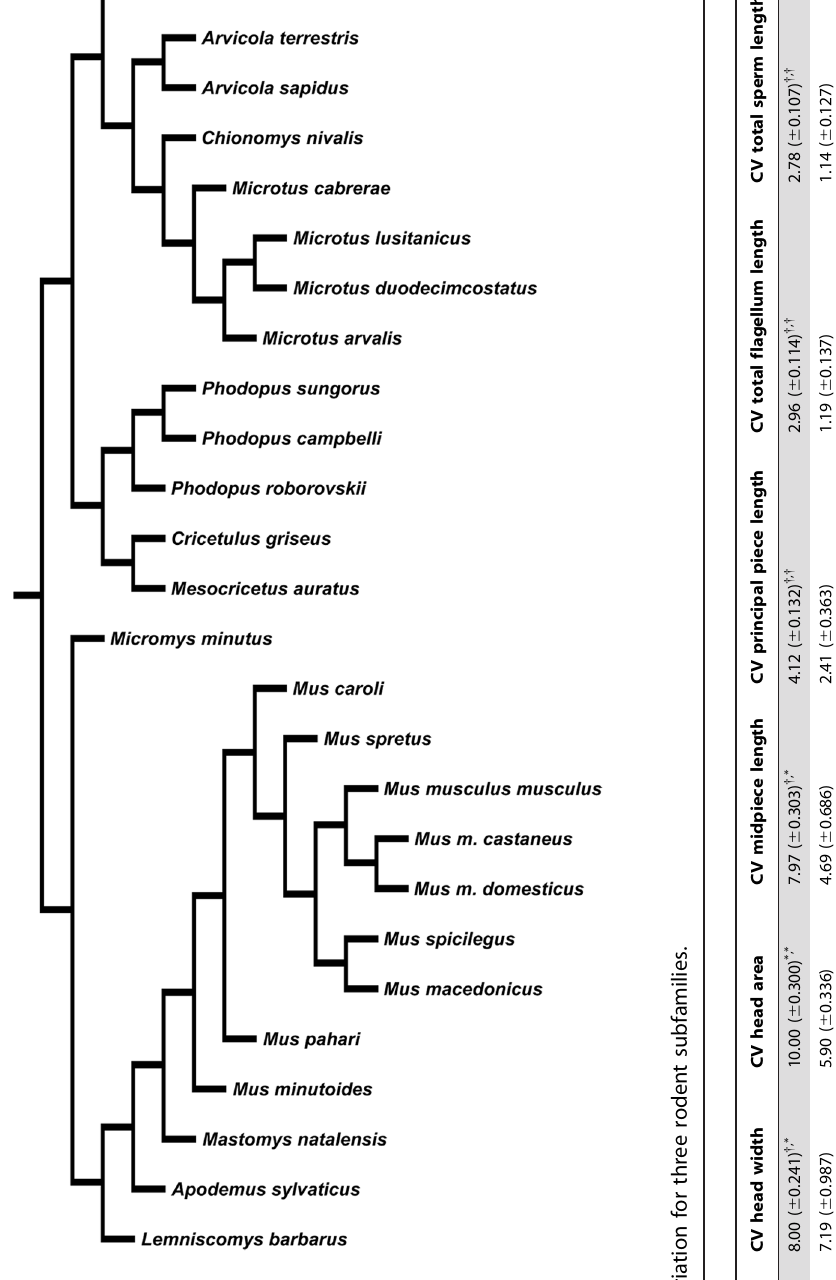
Figure 1. Phylogeny of 26 rodent species used in this study. The phylogenetic tree has been reconstructed from published data [32]. ( t = 4.71, P = 0.009, d.f. = 25). Among the three rodent subfamilies analyzed, Arvicolinae showed the highest CV values, which were statistically different for CVs of sperm head length and sperm area from the other two subfamilies (Cricetinae and Murinae). No statistically significant differences were found between the variation in flagellum components of the three subfamilies, with the exception of the CV of the midpiece length which was significantly higher in Arvicolinae than in Murinae (Table 1). Multiple regression analysis, controlling for phylogenetic effects, revealed a significant and negative relationship between testes